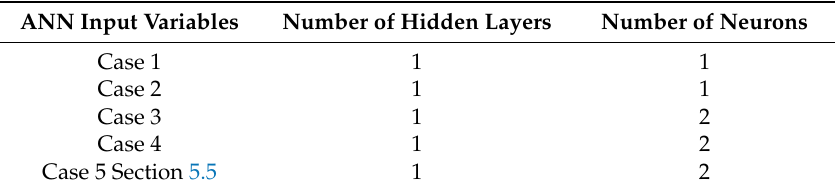
Table 3. ANN’s structure.